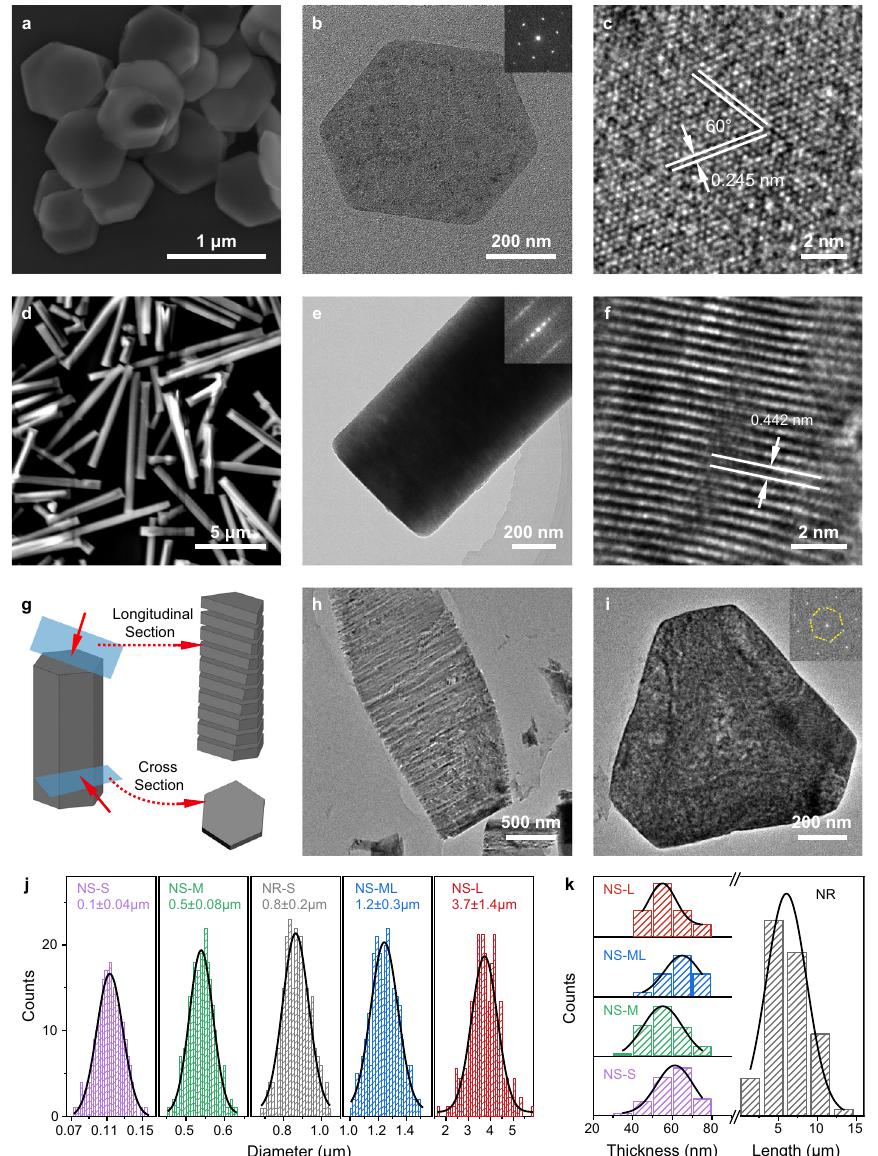
Fig. 1|MicrostructuresofCoOOHNSandNR.a , d SEM images, b ,eTEMimages, and c , f HRTEM images of CoOOH NS-M ( a – c ) and NR ( d – f ); g Schematic illustra- tion of the sectioning of CoOOH NR for TEM observation; h , i TEM images of CoOOH NR after sectioning perpendicular ( h ) and parallel ( i ) to the basal surface. The NR in ( h ) disintegrated, and it should result from the shear stress in the sectioningprocedure; j BasalplanesizedistributionofNSandNR.Standarderrors